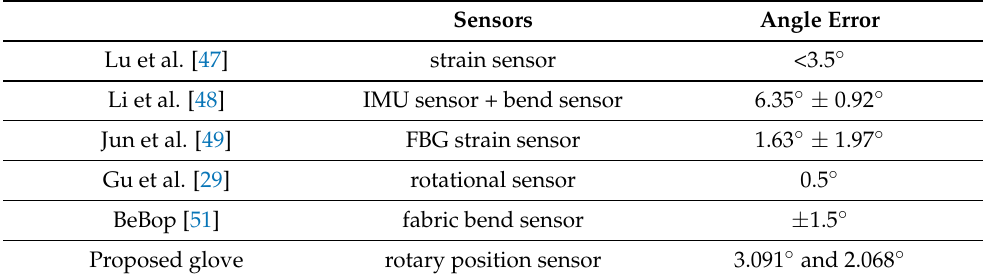
Table 4. Comparison of motion-tracking error with other methods found in the literature.